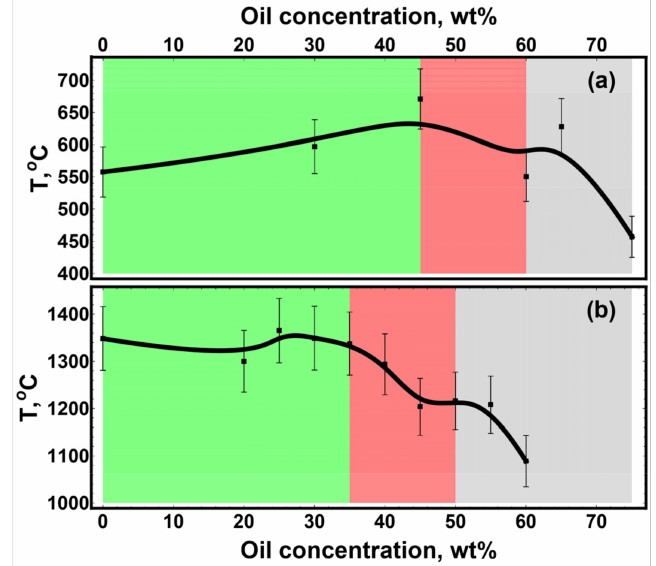
Figure 3. Average temperatures during conversion for P + RO ( a ) and L + RO ( b ) fuel compositions. The red zone corresponds to fuel conversion. The green and gray zones correspond to compositions with excess production of CO 2 and extremely low overall gas production.